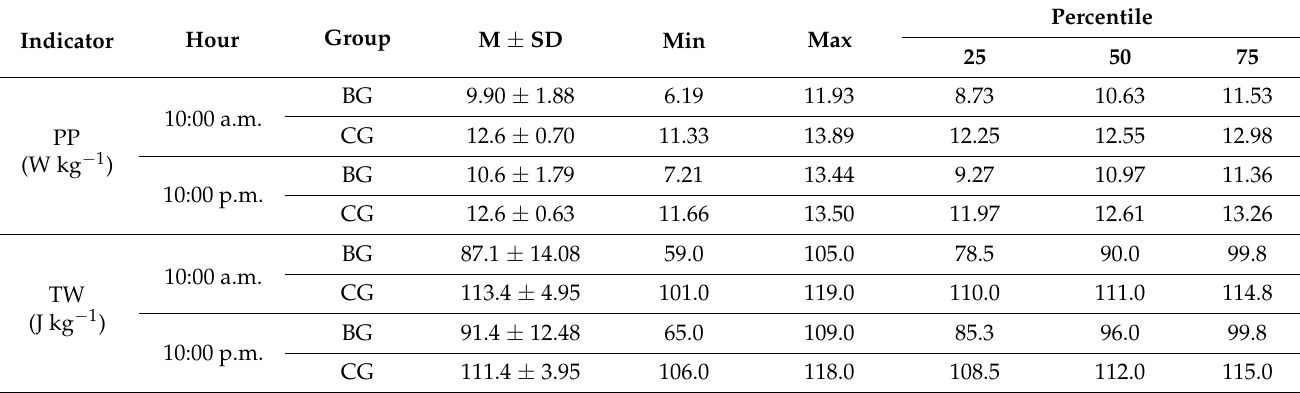
Table 1. Peak power and total work in anaerobic effort in blind